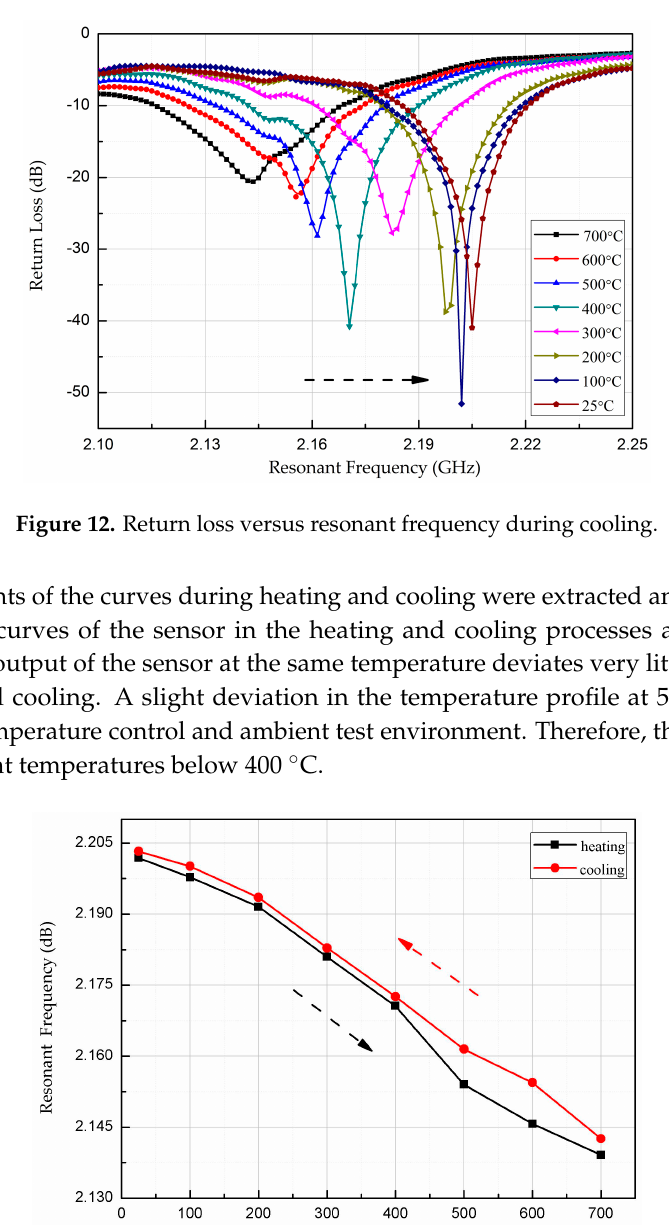
Figure 11. Valley resonant frequency versus temperature during heating.